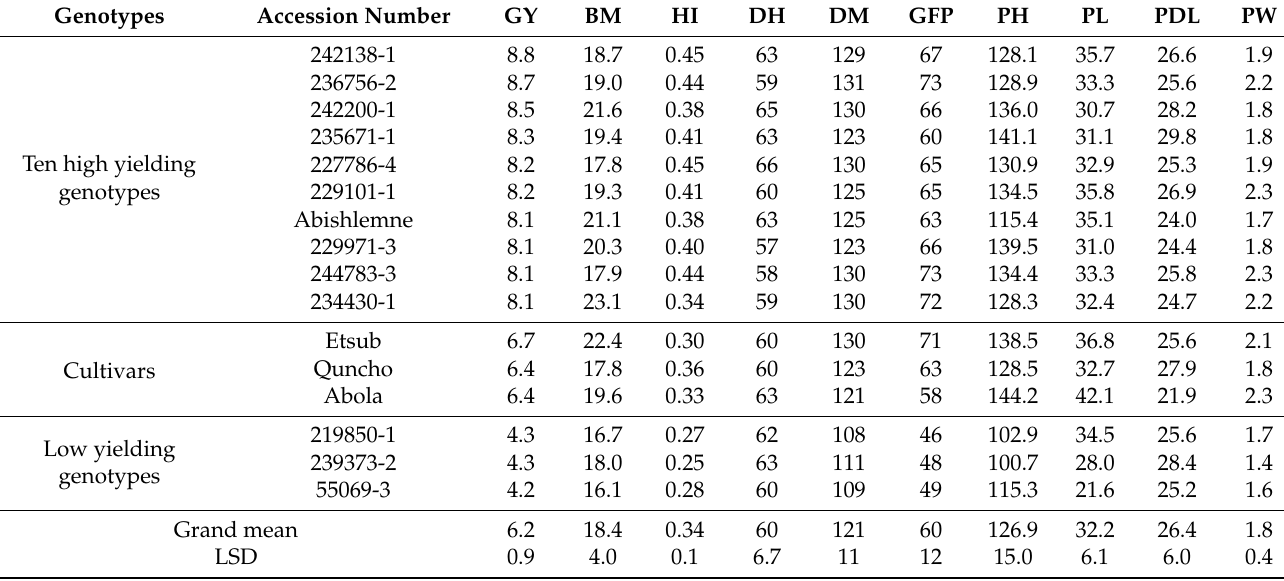
Table 1. Best linear unbiased predictor (BLUP)-adjusted mean grain yield and yield-related traits of the top ten high yielding, cultivars, and the bottom three low yielding teff genotypes under the intensive growing condition. Genotypes